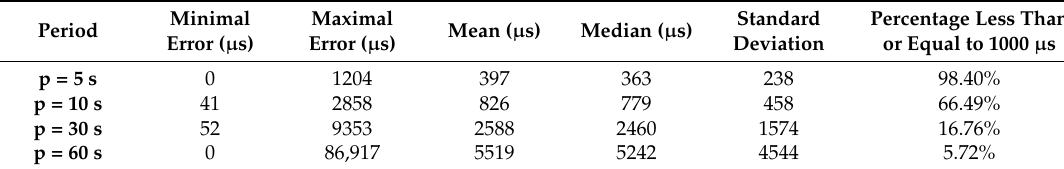
Table 3. Results obtained in the precision experiment with the LSI as clock source, for the global traces synchronization.